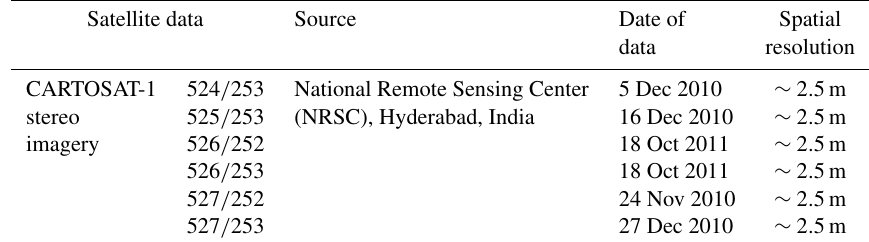
Table 2. Details of the satellite imagery.